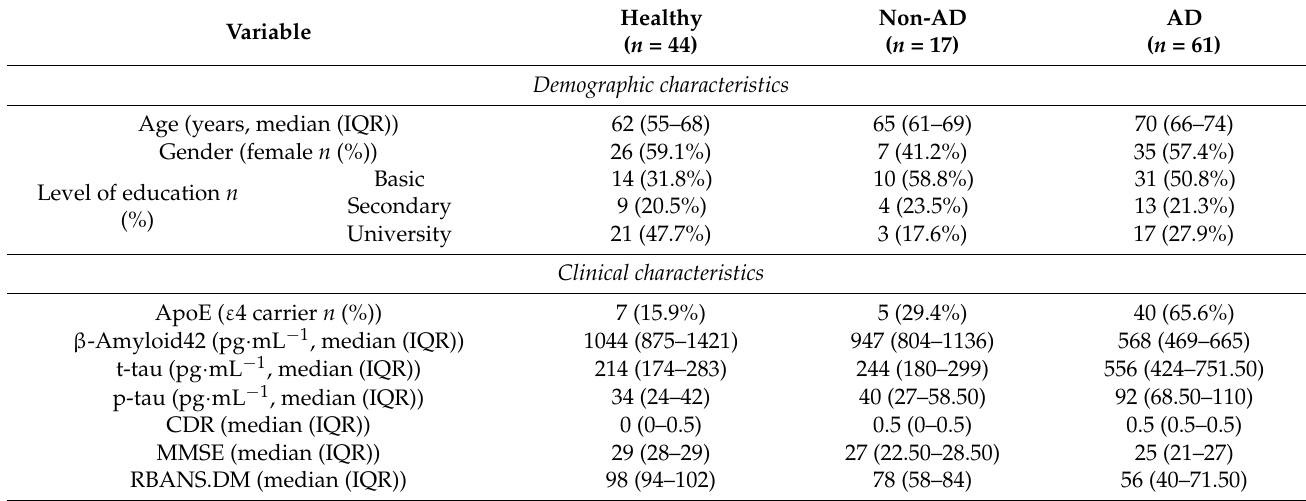
Table 1. Participants’ demographic and clinical